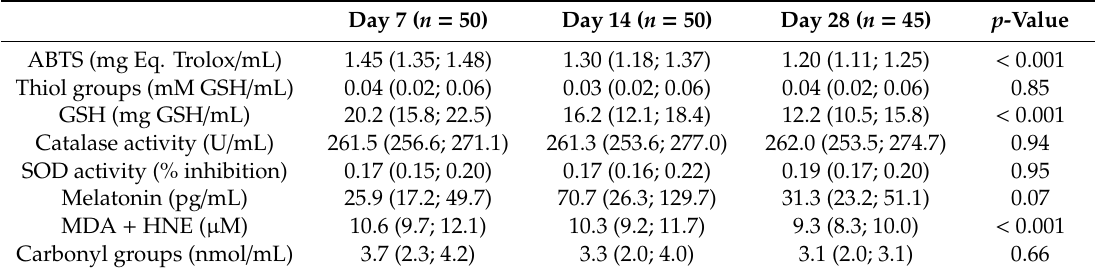
Table 1. Breast milk antioxidants and oxidative damage biomarkers at days 7, 14 and 28 of